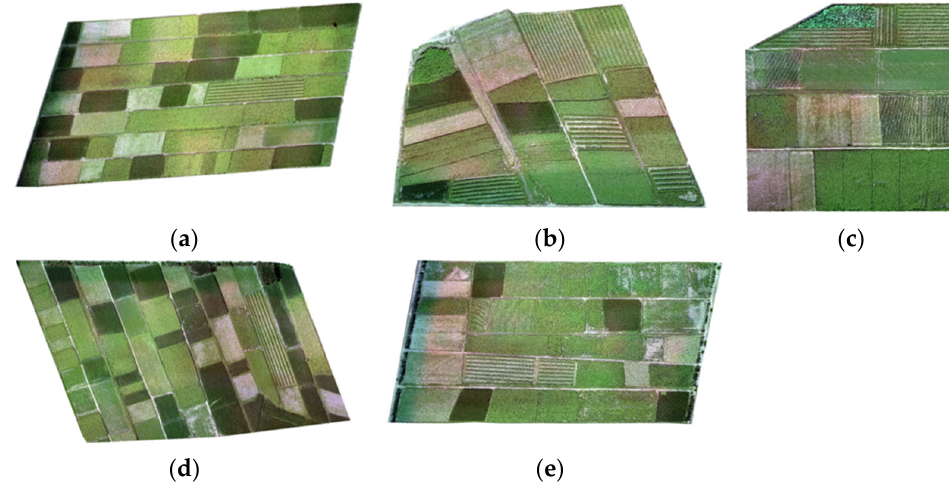
Figure 3. The UAV orthoimages collected on different dates. ( a ) 27 July 2020, ( b ) 28 July 2020, ( c ) 9